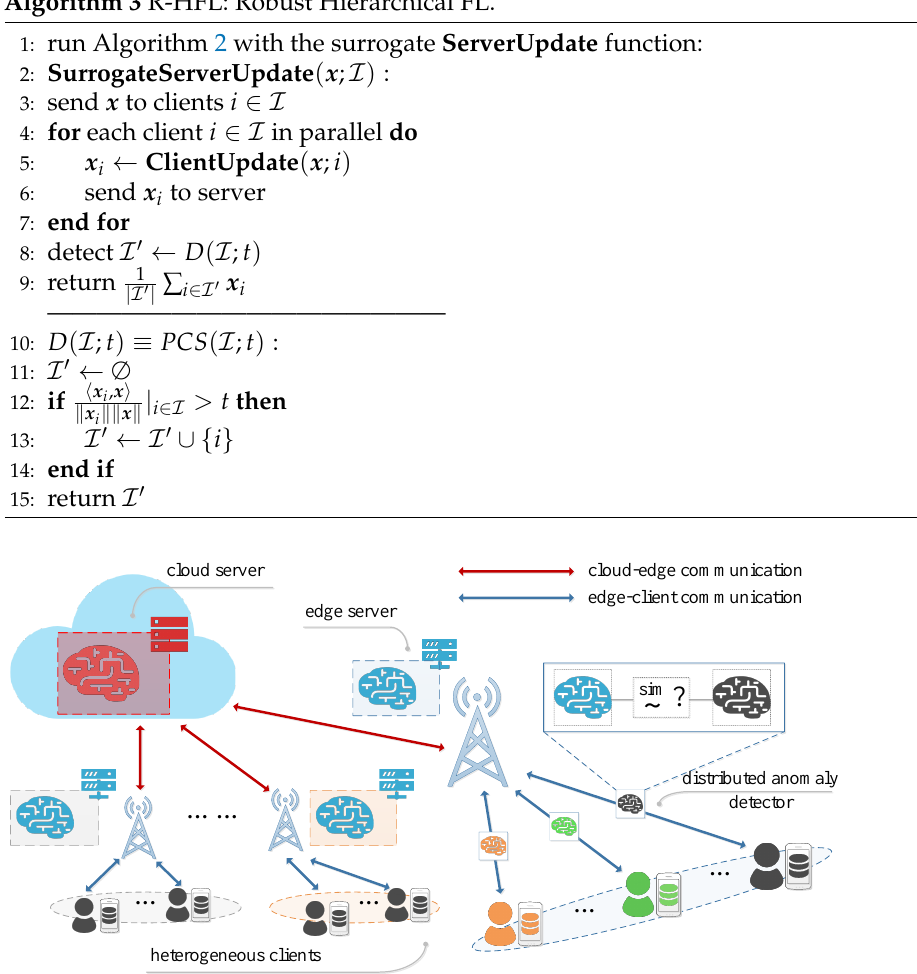
Figure 1. R-HFL system with cloud–edge–end cooperation: cloud and edge servers cooperatively generate global FL models from participating end devices. Detectors are deployed at the edges to filter malicious clients in parallel, which are built by the PCS mechanism that compares the local model with the aggregated edge